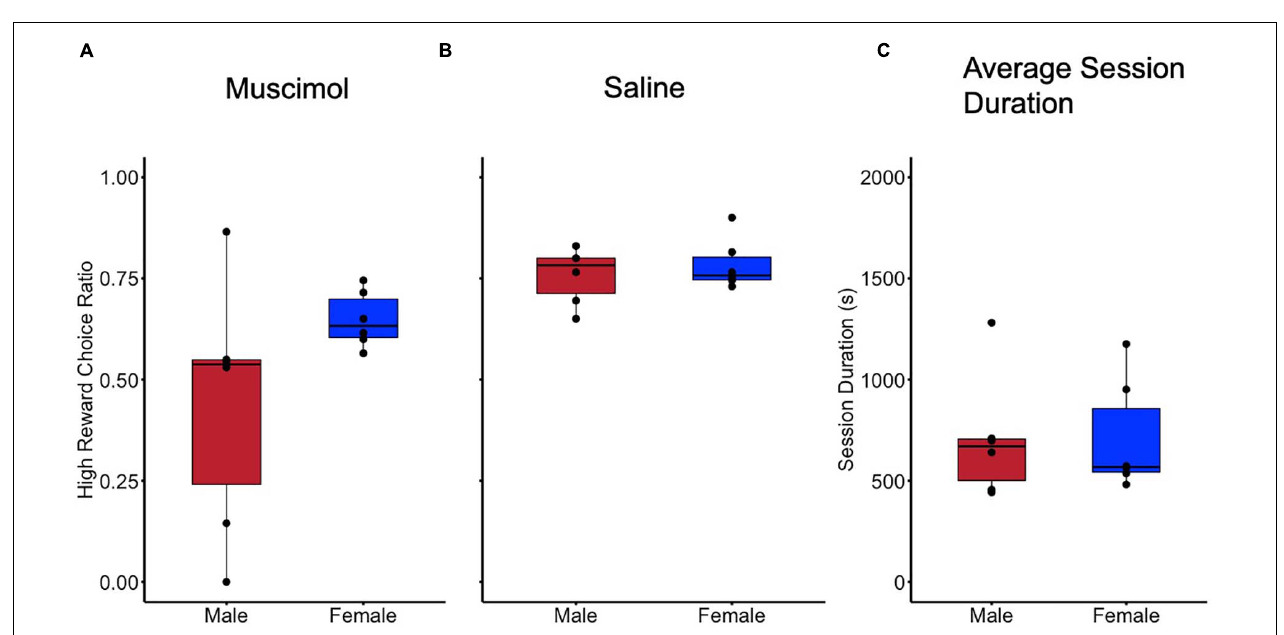
FIGURE 3 | Inactivation of the LHb decreased preference for the high effort, high reward arm. (A) High reward choice comparison between inactivation (Muscimol) and control (Saline) sessions with the high 30 cm ramp in place. (B) High reward choice comparison between inactivation and control sessions with no ramp in place. (C) Session duration compared between inactivation and control sessions. * = p < 0.01.